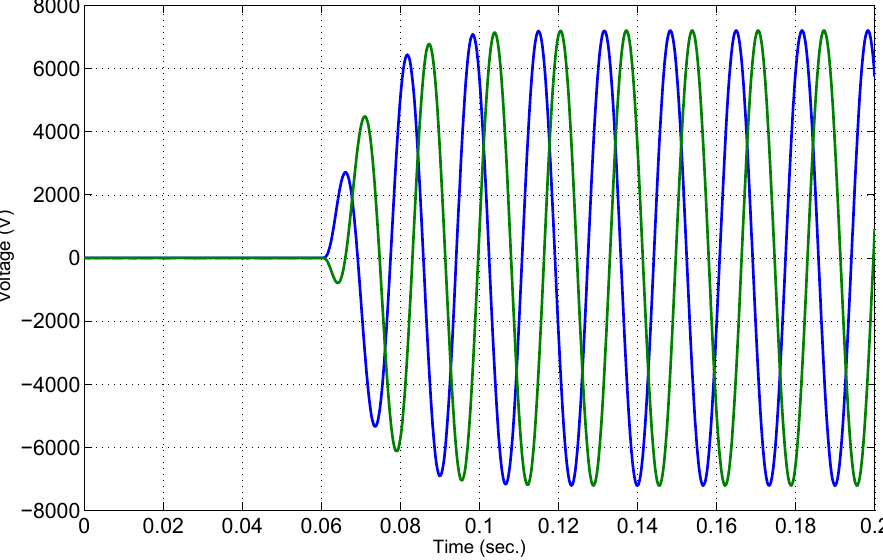
Figure 10. The phase a and b voltages of the load generated by the